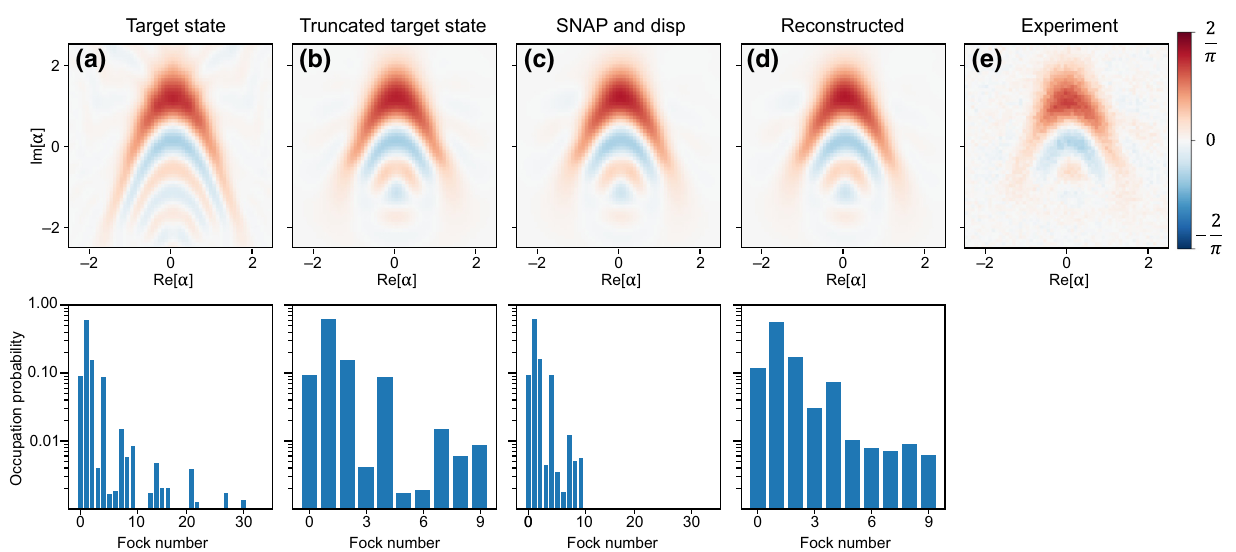
FIG. 6. Comparison of the Wigner functions and occupation probability of, from left to right, the target cubic phase state, the target cubic phase state truncated to the first 10 Fock states, the state prepared by three SNAP gates and three displacements, the reconstructed state limited to the first 10 Fock states, and the Wigner function of the experimental data.